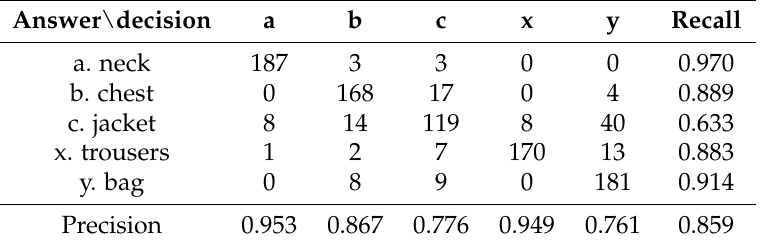
Table 11. Confusion matrix of LOSO-CV for the merged 5-class classification (averaged per